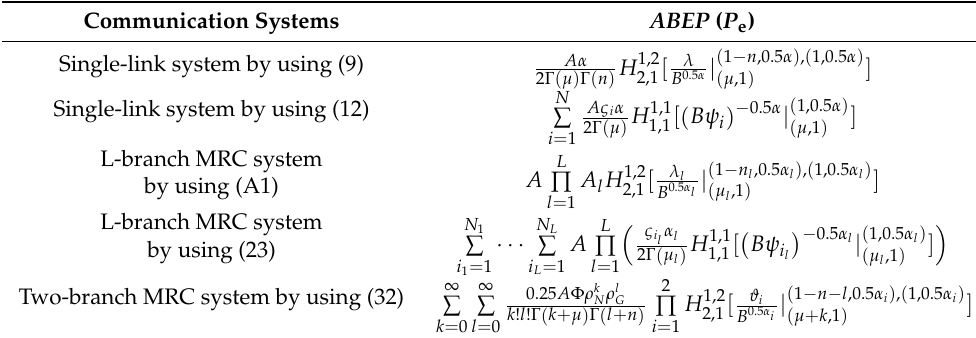
Table 3. ABEP expressions of DPSK for various systems. Communication